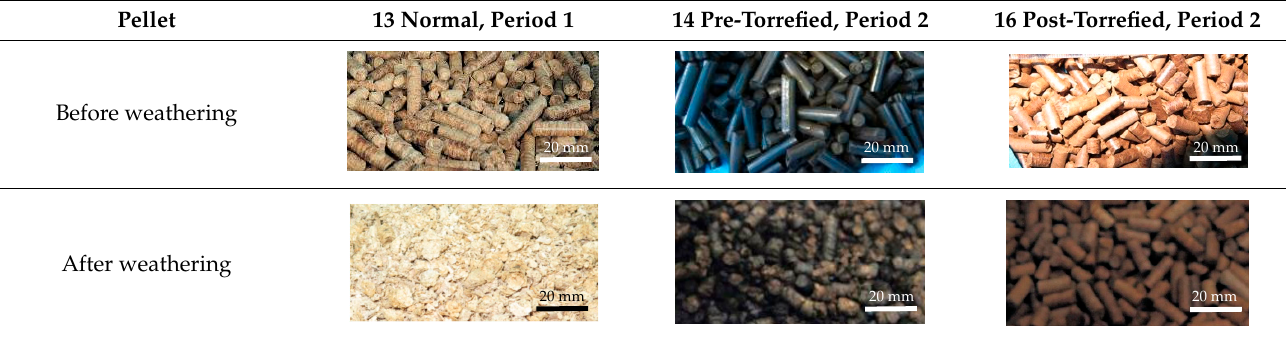
Table 4. Visual observation of the pellets before and after weathering without a roof.